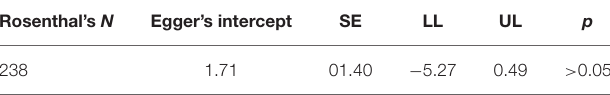
TABLE 4 | Publish deviation test results.